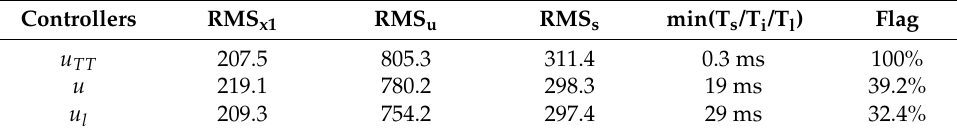
Table 2. Performance indices of different controllers in TT and ET